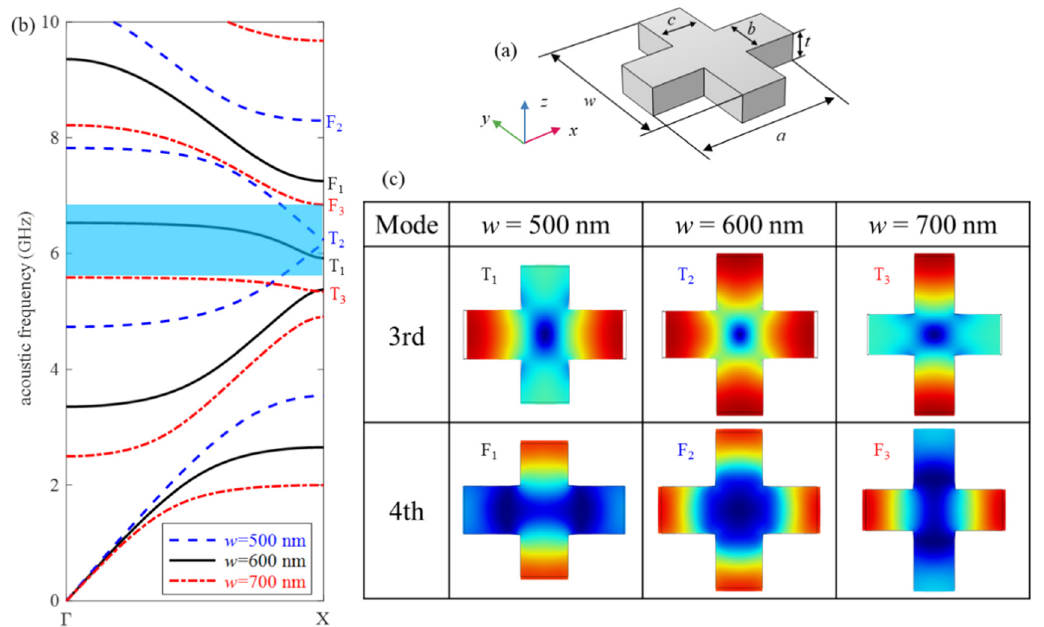
Figure 2. ( a ) A cross-shaped unit cell. ( b ) Acoustic band structure of ee symmetry modes for w = 500, 600, and 700 nm, respectively. ( c ) Mode shapes of the 3rd (denoted by T) and 4th (denoted by F) modes for different w .